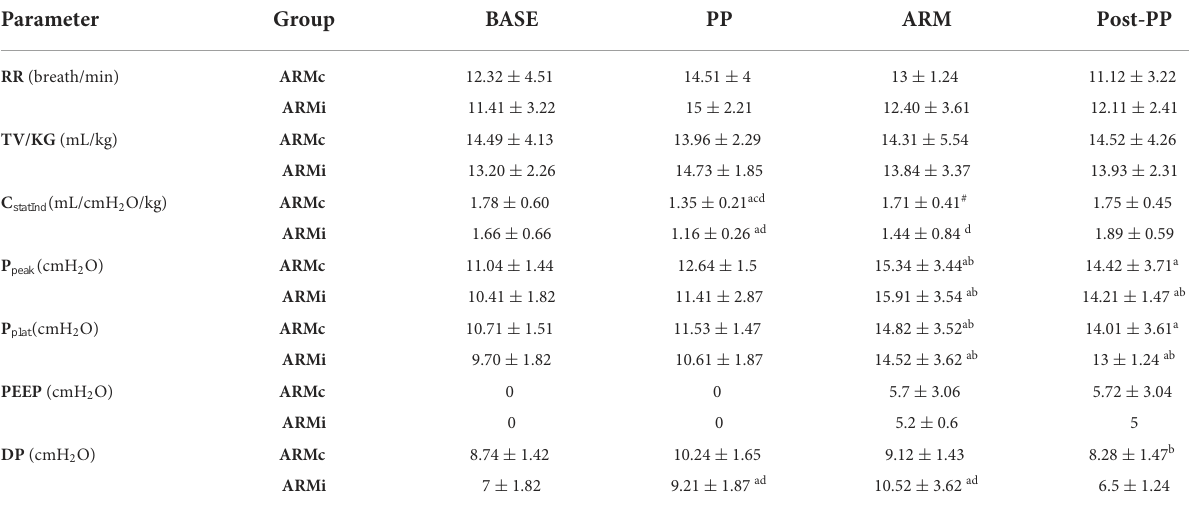
TABLE 1 Mean ± SD of the respiratory parameters evaluated in 20 dogs mechanical ventilated, undergoing laparoscopic surgery. Parameter Group BASE PP ARM